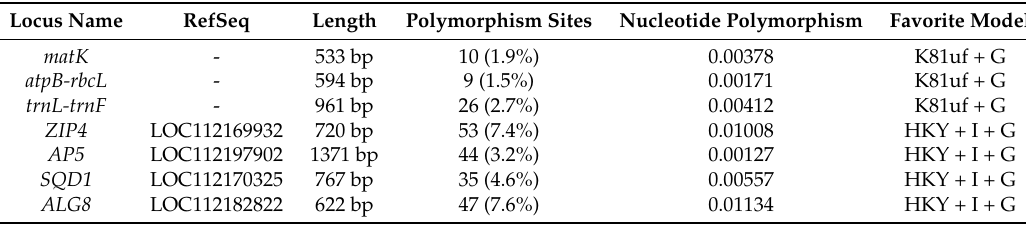
Table 3. Genetic diversity of gene